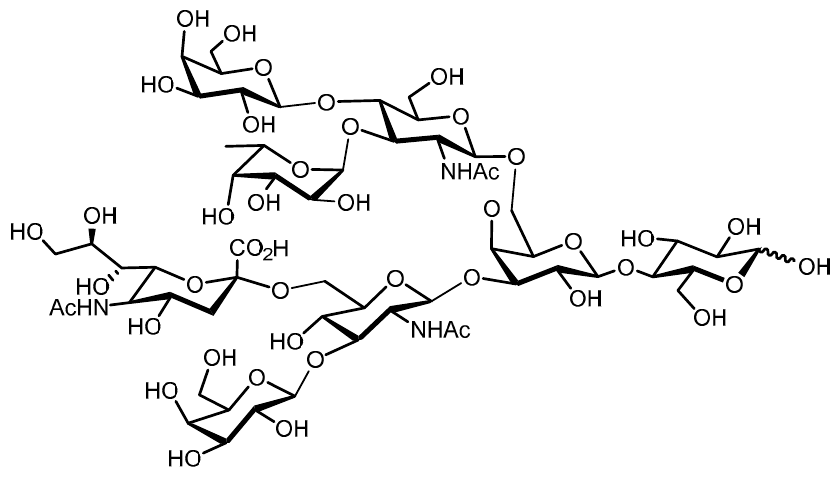
Figure 1. Exemplary structure of an HMO.